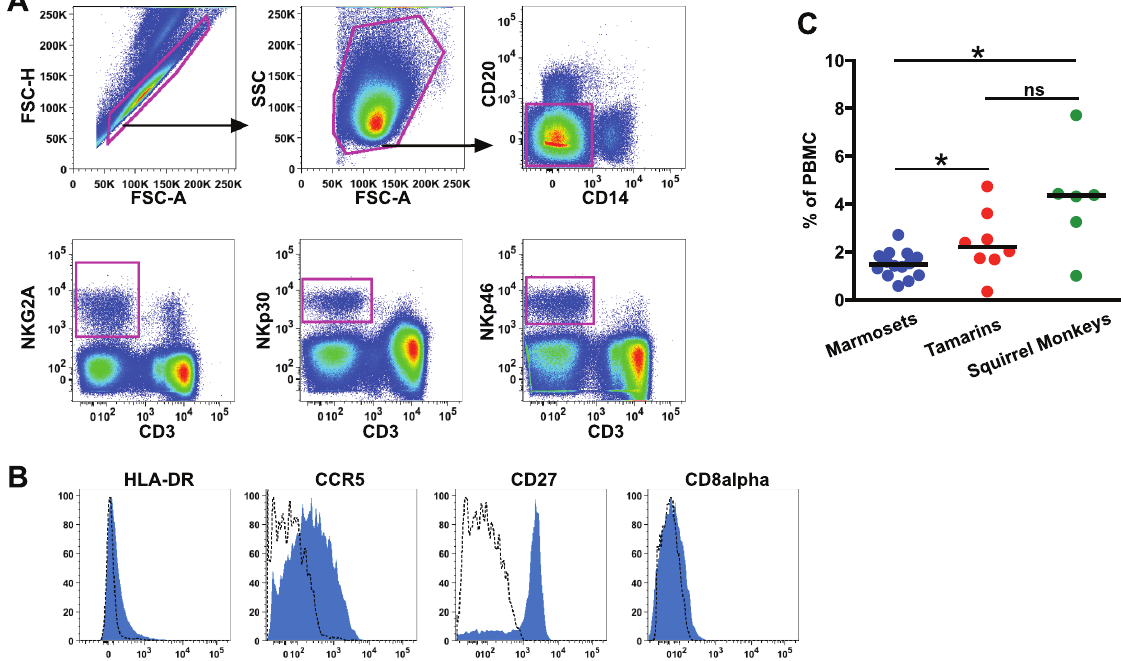
Figure 1. Peripheral blood NK cells in neotropical primate species. ( A ) Representative gating strategy identifying circulating NK cells. ( B ) Representative histograms of secondary molecule expression on NK cells as gated in A. ( C ) Cross-sectional comparisons of NKp46 + NK cell frequencies among total mononuclear cells in different neotropical primate species. Bars represent medians. Mann-Whitney U tests were used for interspecies comparisons; *, P , 0.05; ns, not significant.